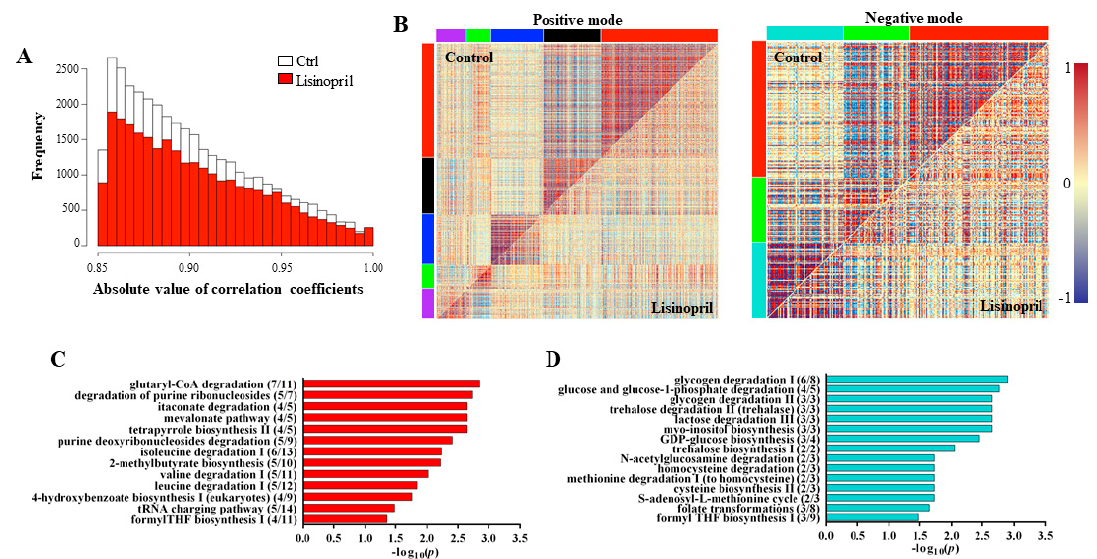
Figure 5. Lisinopril perturbs the thoracic metabolic network structure. ( A ) Distribution of extreme pairwise metabolic feature correlation coefficients. Pairwise Pearson correlations were performed on all metabolic features from positive and negative mode within Control samples ( n = 18) and Lisinopril samples ( n = 18). Shown are the distributions of correlation coefficients with an absolute value greater than 0.85 for each treatment. ( B ) Heat maps of correlated metabolite features detected in positive ion mode (three modules) and negative ion mode (five modules). Each point represents the correlation between two metabolite features and the color scale bar indicates the value of the correlations. ( C , D ) Representative pathways in the red module for metabolite features detected in positive mode (panel C ) and in the turquoise module for metabolite features detected in negative mode (panel D ). Numbers in parentheses indicate overlap size/pathway size.